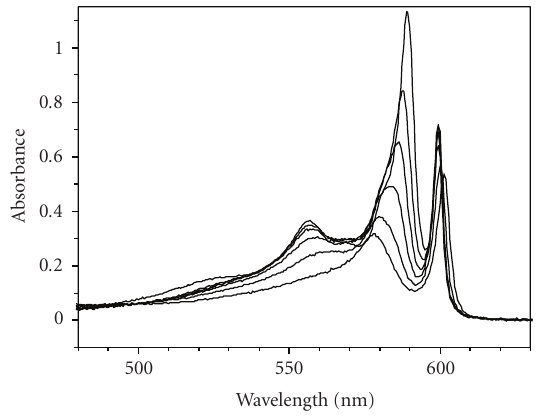
Figure 2: Absorption spectra of a 5 × 10 − 6 M solution of C8S3 upon titration with Na 2 PdCl 4 under presence of the reducing agent 406 (ATTOTEC). End concentration of Na 2 PdCl 4 : 6 × 10 − 6 mol · l − 1 , titration step: 1 × 10 − 6 mol · l − 1